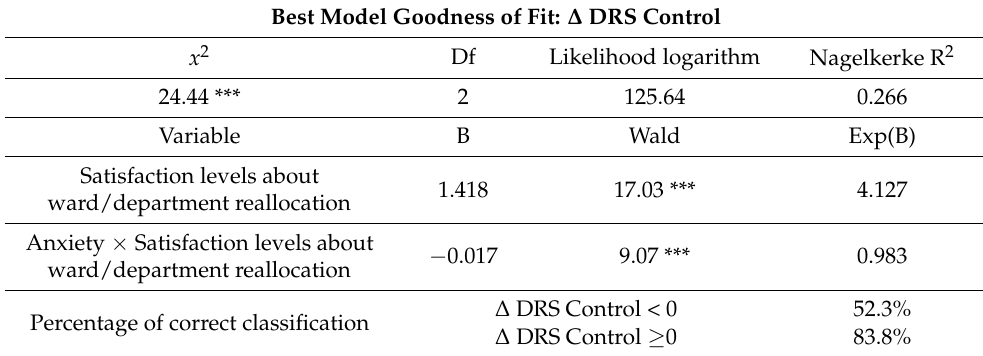
Table 21. Control predictors according to multivariate analysis (transfer evaluation, anxiety × transfer evaluation) and correct/incorrect classification of the model.